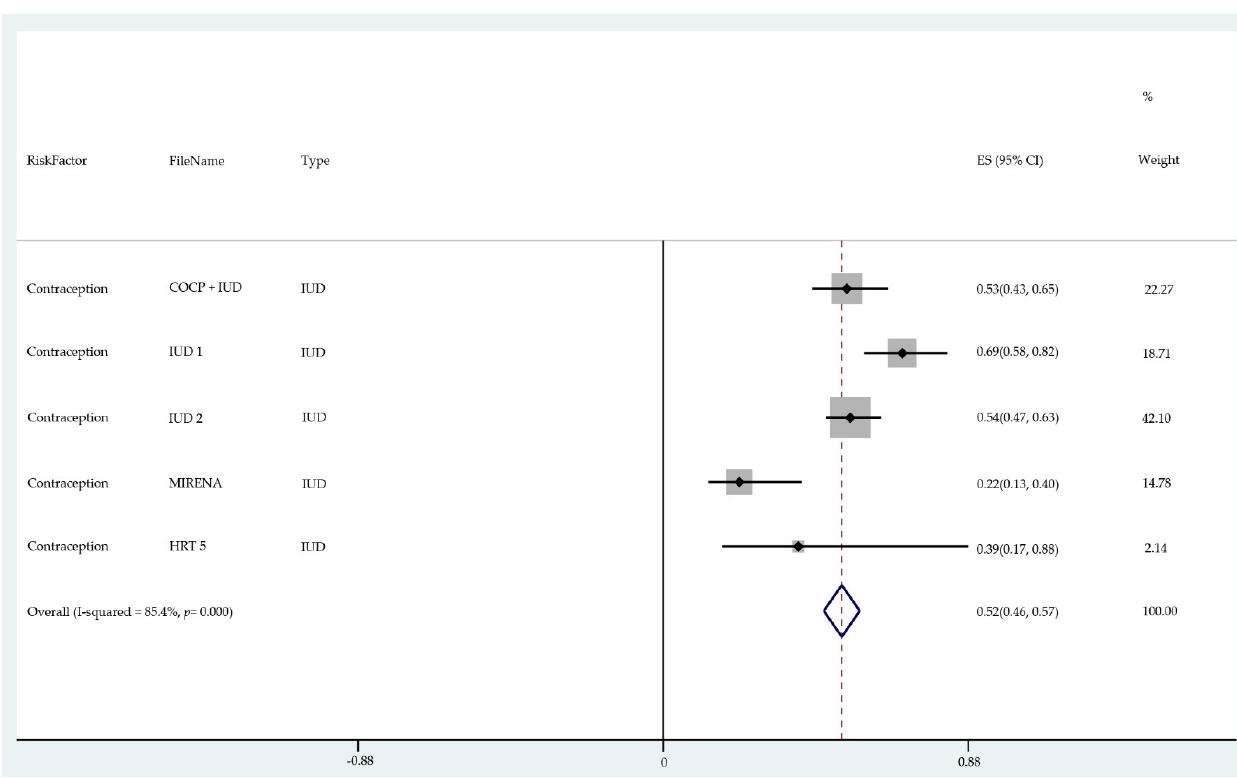
Figure 6. Forest plot to show risk of noncontinuous HRT.